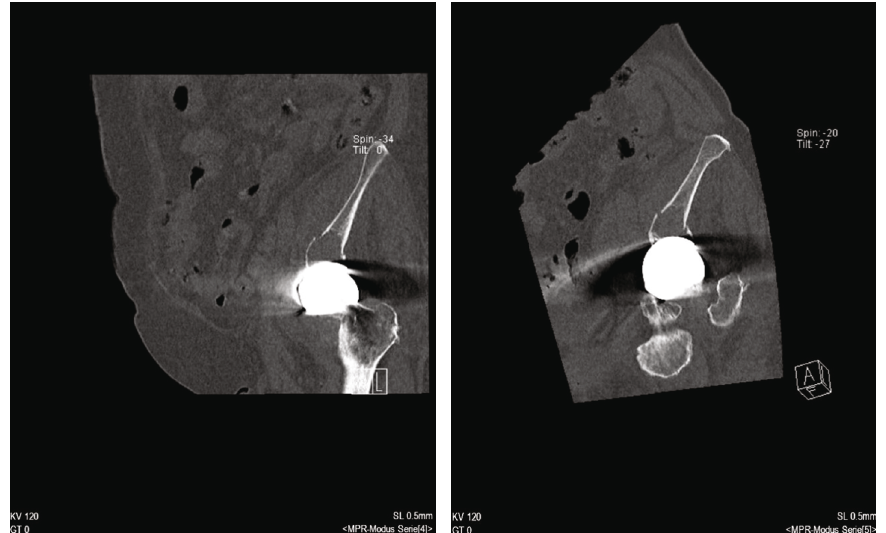
Figure 2: Preoperative CT of the pelvis. (a) shows the large osteolysis in the sagittal plane. (b) is the corresponding coronal plane of the patient ’ s left hip.